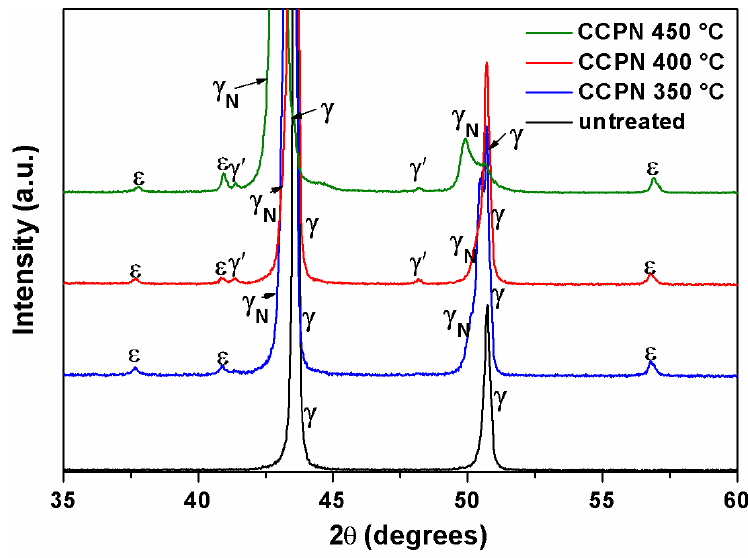
Figure 7. X-ray diffractograms of samples untreated and nitrided by CCPN AISI 316 at different temperatures.